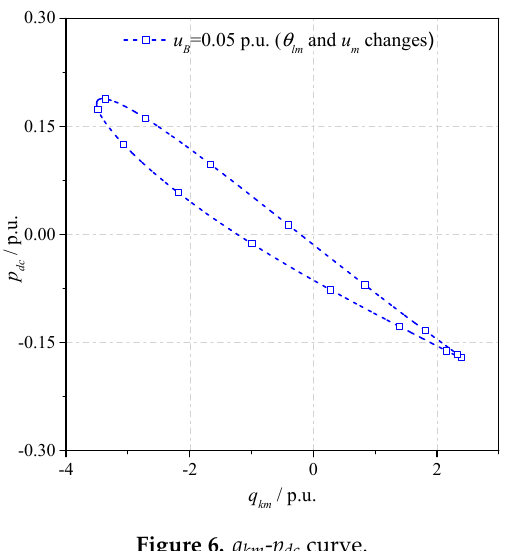
Figure 6. q km - p dc curve.